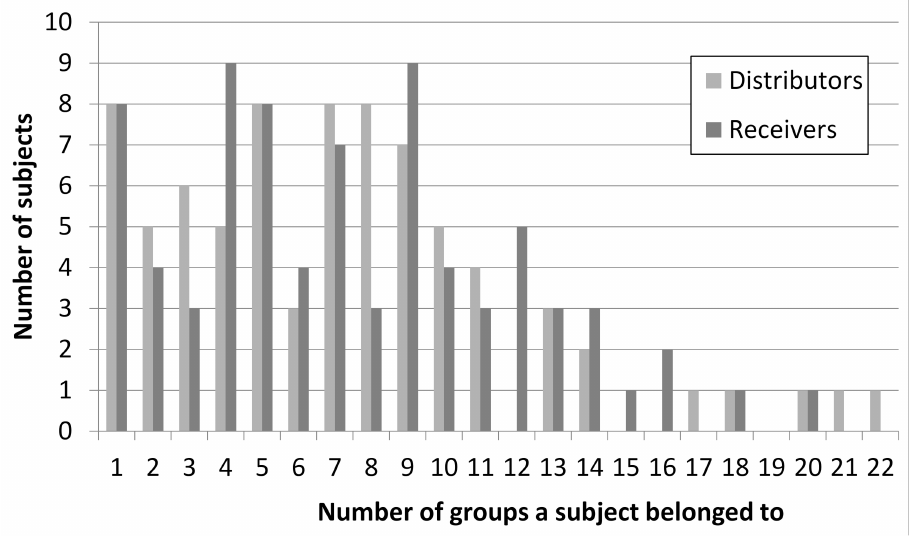
Figure 4. How many subjects belonged to a specific number of groups during the